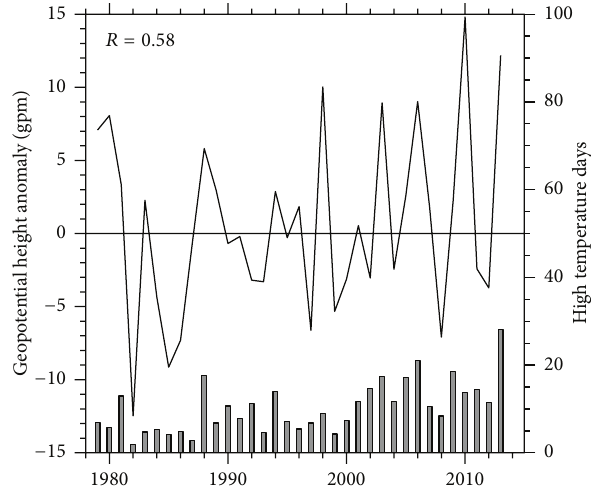
Figure2:Theanomalyof500 hPaaveragegeopotentialheight(gpm, solid line) and the total HDs (days) of observation stations (bar) in region A in the summer of 1979–2013. The total HDs are reduced 100